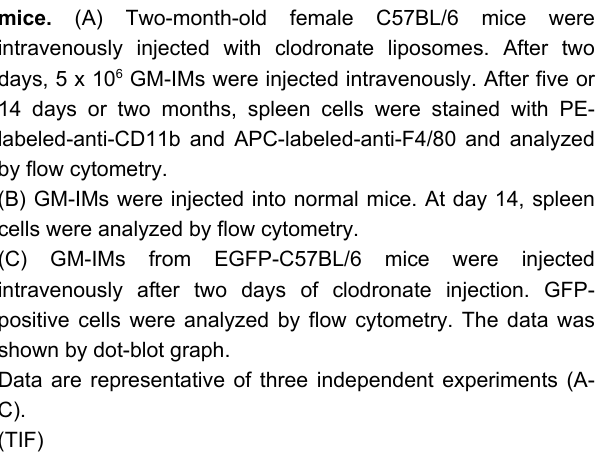
Figure S2. Microarray analysis of GM-IMs compared with BMDCs. The heat map represents log